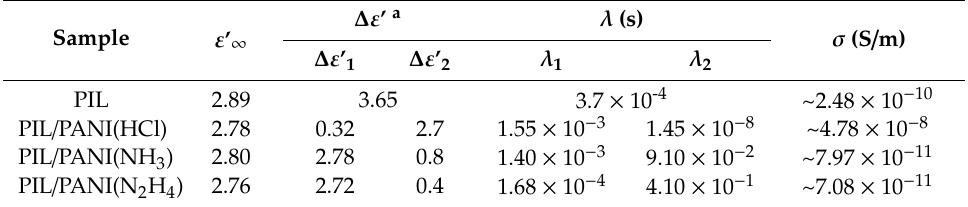
Table 1. Dielectric characteristics of the ER fluids of PIL/PANI. ( T = 30 °C) Sample